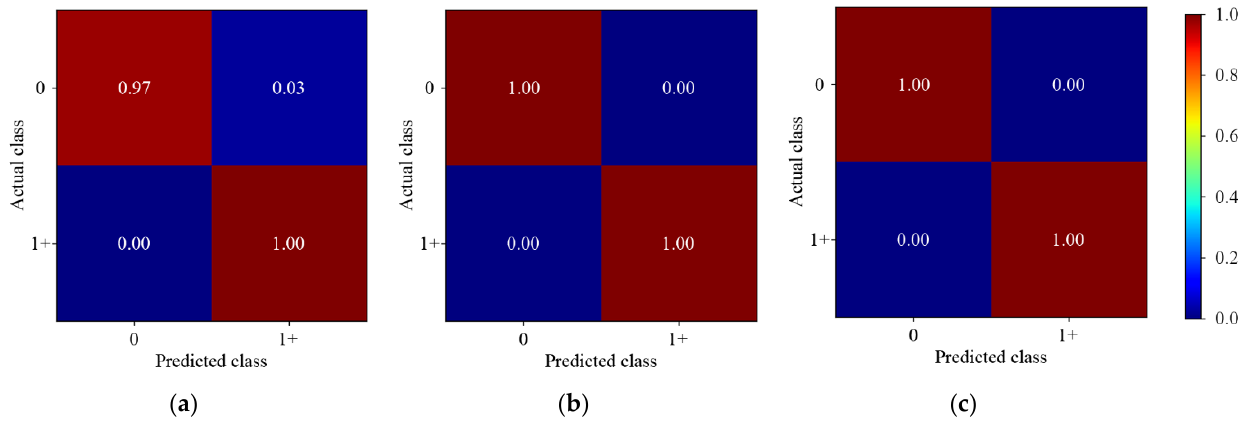
Figure 5. The normalized confusion matrix for pesticide residue discrimination. ( a ) Single-depth 1D-CNN; ( b ) Symmetric multiscale 1D-CNN; ( c ) Asymmetric multiscale 1D-CNN. Label 0 represents samples without pesticide residues; Label 1+ represents samples with pesticide residues.